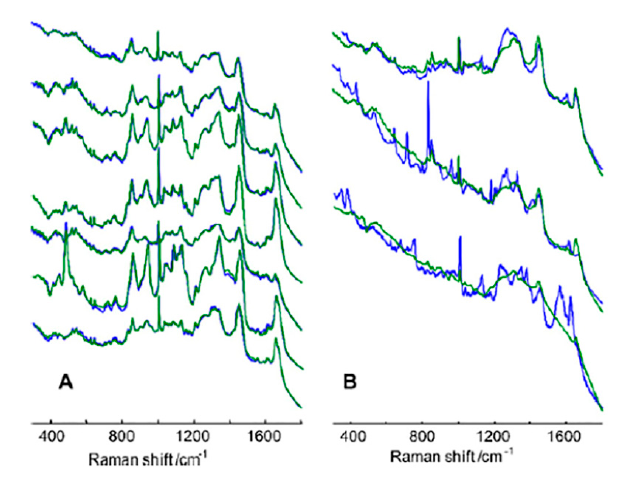
Figure 10. The average Raman spectra of seven vaginal fluid samples ( A ) and the Raman spectra of saliva, semen and blood ( B , top, middle and bottom lines, respectively) with the fitted spectroscopic signature of vaginal fluid [136].